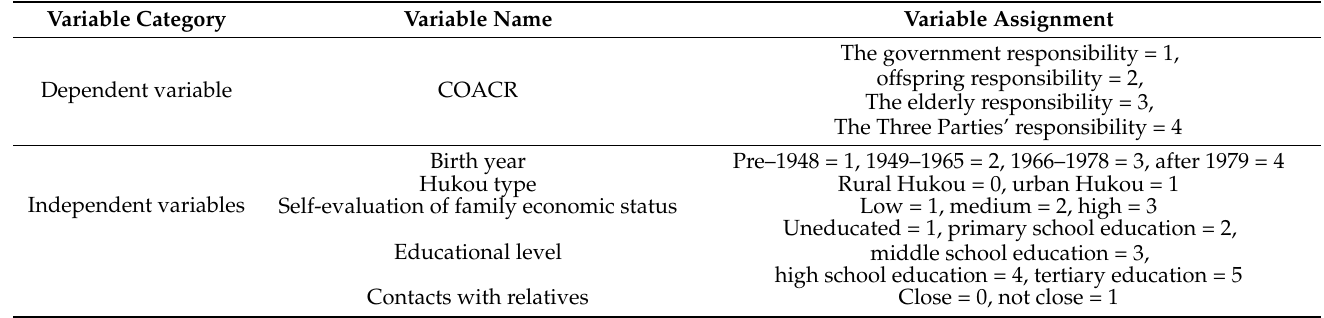
Table 2. Variable